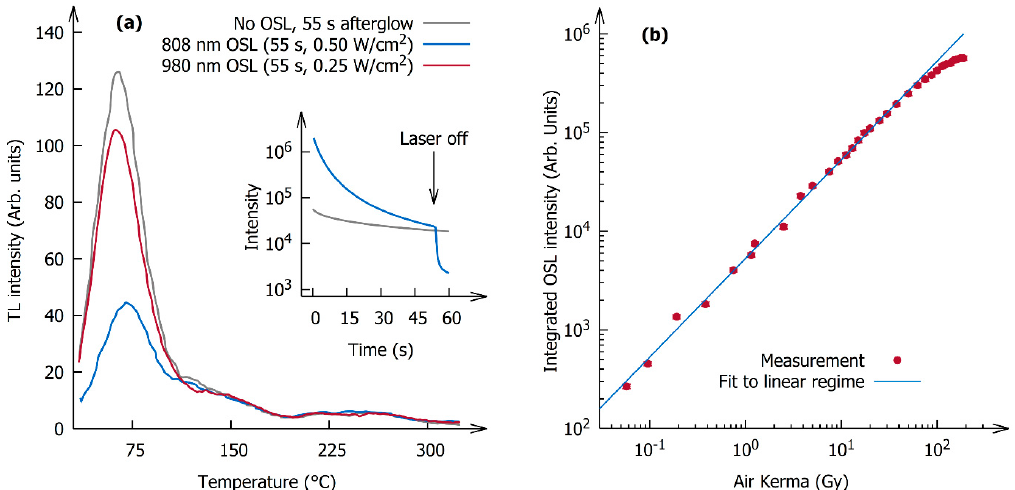
Figure 4. ( a ) Afterglow and thermoluminescence (TL) curves with and without optical